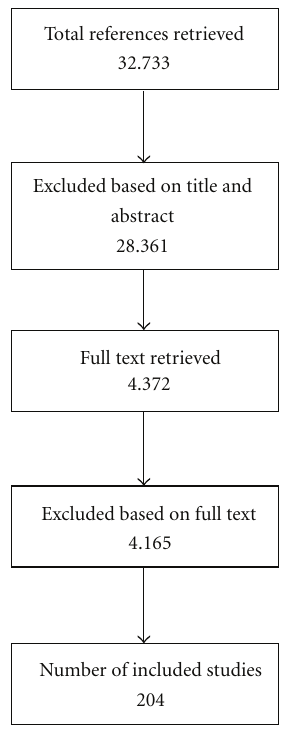
Figure 1: Distribution of included universal preventive studies.